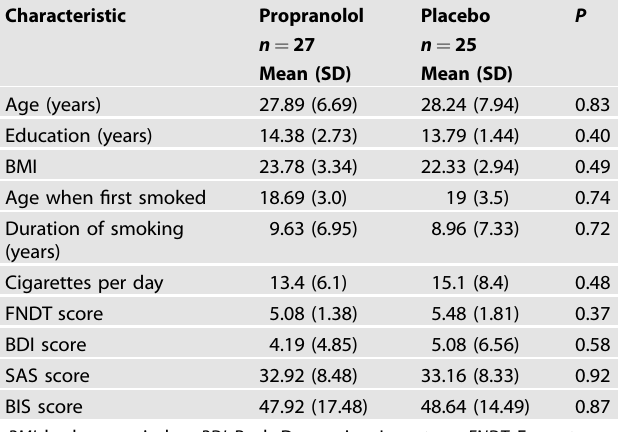
Table 1. Demographic data and psychological traits of the participants in each group.